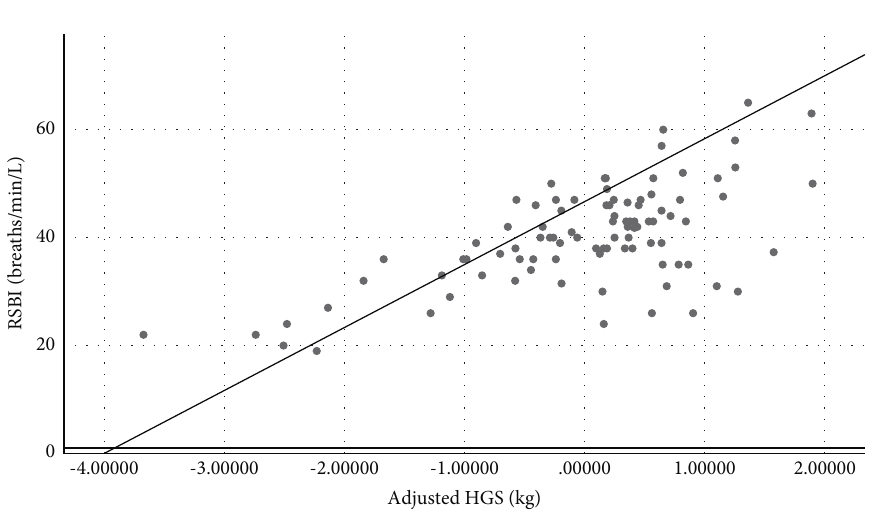
Figure 2: Linear regression analysis showing the correlation between rapid shallow breathing index (RSBI) and handgrip strength (HGS) at 10min before spontaneous breathing trial (SBT) adjusted by age, gender, and acute physiology and chronic health evaluation II score. Table 3: Linear regression analysis for rapid shallow breathing index and handgrip strength, age, gender, and APACHE II score. Variables Regression coefficients Intercept < 0.001